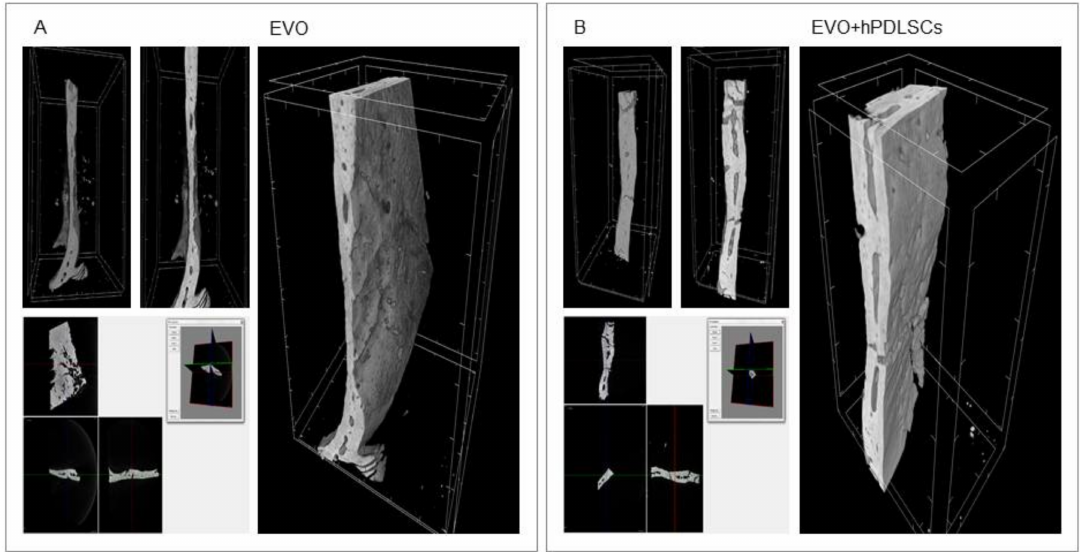
Figure 6. Micro-computed tomography (CT) analyses. 3D volume rendering and 2D virtual sectioning in the 3 orthogonal planes of EVO ( A ) and EVO + hPDLSCs ( B ).